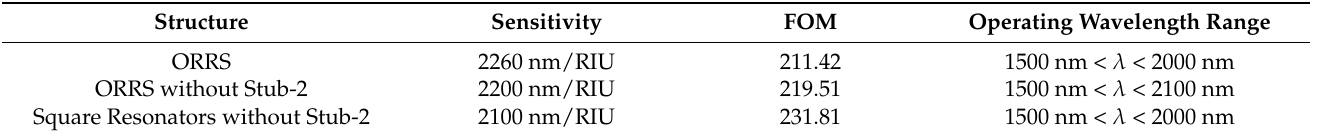
Figure 6. ( a ) Transmission spectra at various angles; ( b ) S changes under different angles. Table 2. Comparison with data from different structures.